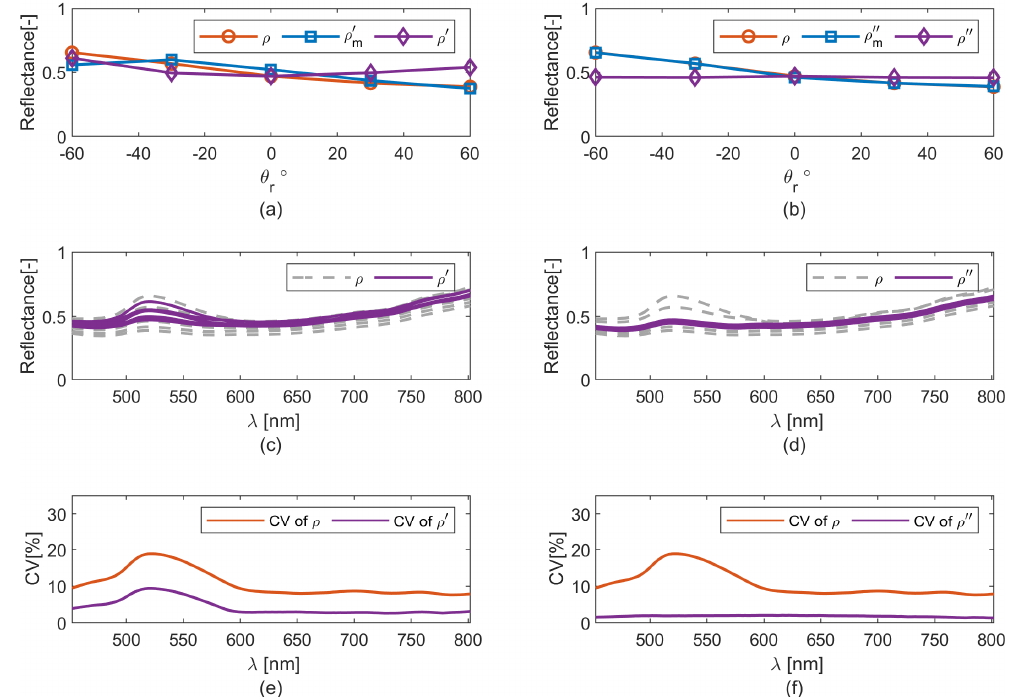
Figure 4. Evaluation of the BRDF correction models for the microstructure pattern C. Left and right columns, correction without considering and considering the spectral mixture, respectively. The second row presents the measured pixels' reflectance signatures before the BRDF correction (gray dashed lines) and after the correction (solid magenta lines). The third row shows the CV for each band before and after the